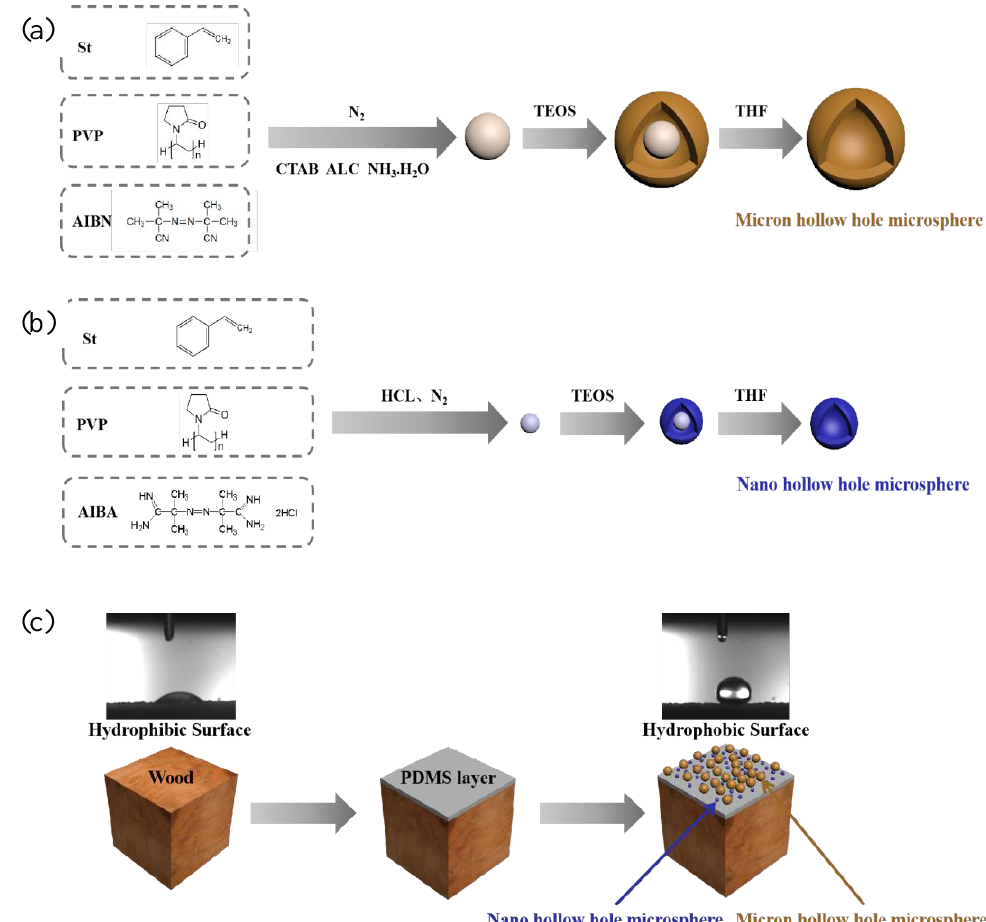
Figure 1. Schematic illustration of preparation process. ( a ) Construction of micron hollow hole microsphere; ( b ) construction of nano hollow hole microsphere; ( c ) description of superhydrophobic surface formation on wood.